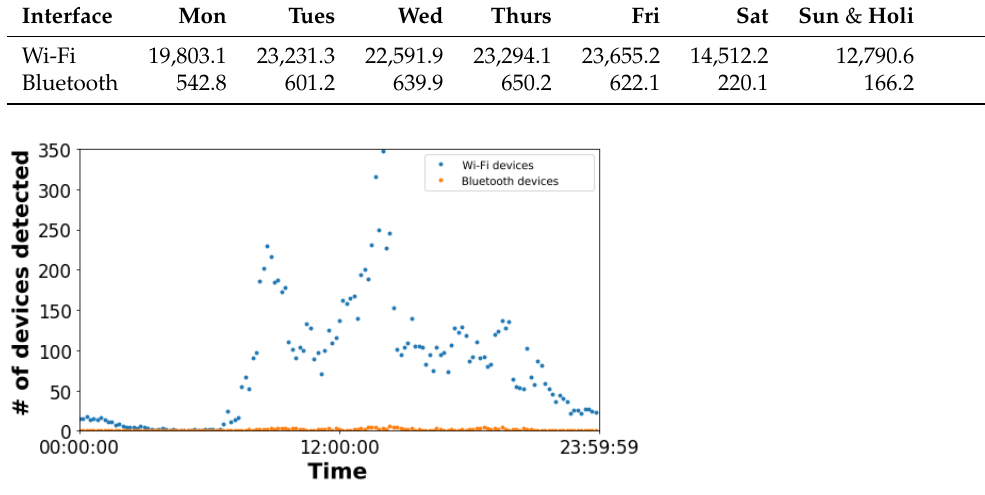
Figure 5. Average value of the number (#) of devices detected for both Bluetooth and Wi-Fi